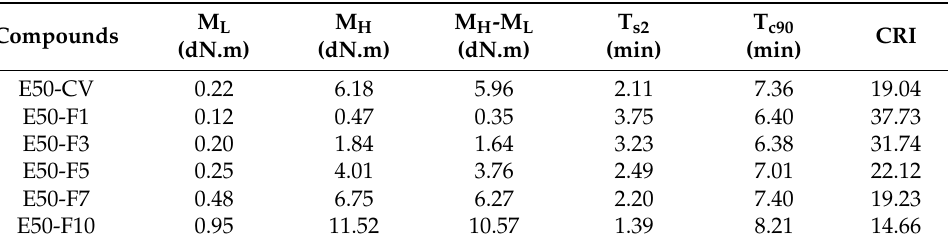
Figure 2. A proposed reaction mechanism between epoxidized natural rubber and ferric chloride. The nucleophilic chloride is attached with β position with respect to the methyl group.